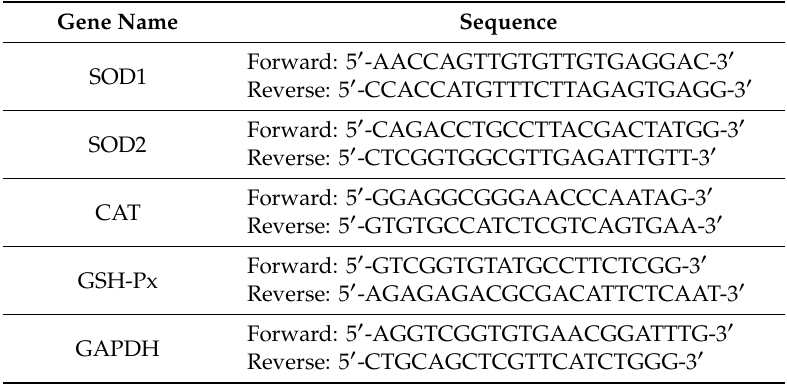
Table 1. The sequences of reverse transcription-polymerase chain reaction